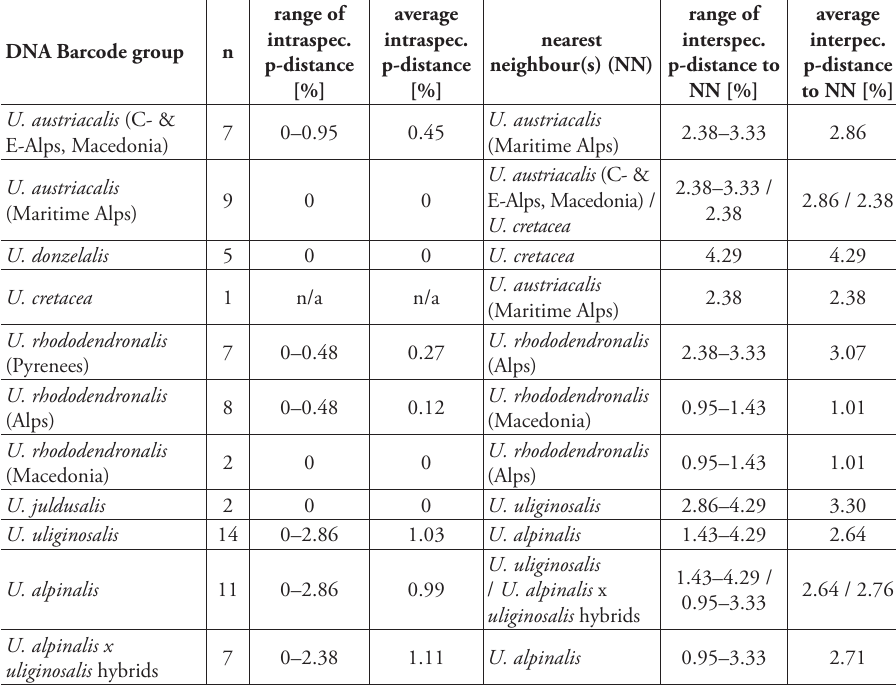
Table 3. COI Barcode p-distances of the systematically investigated Udea populations.